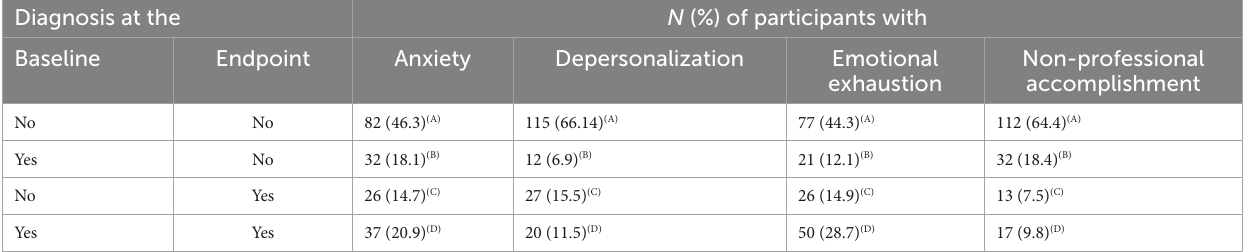
TABLE 3 Clinical characteristics of the four groups regarding anxiety, depersonalization, emotional exhaustion, and professional accomplishment. Diagnosis at the